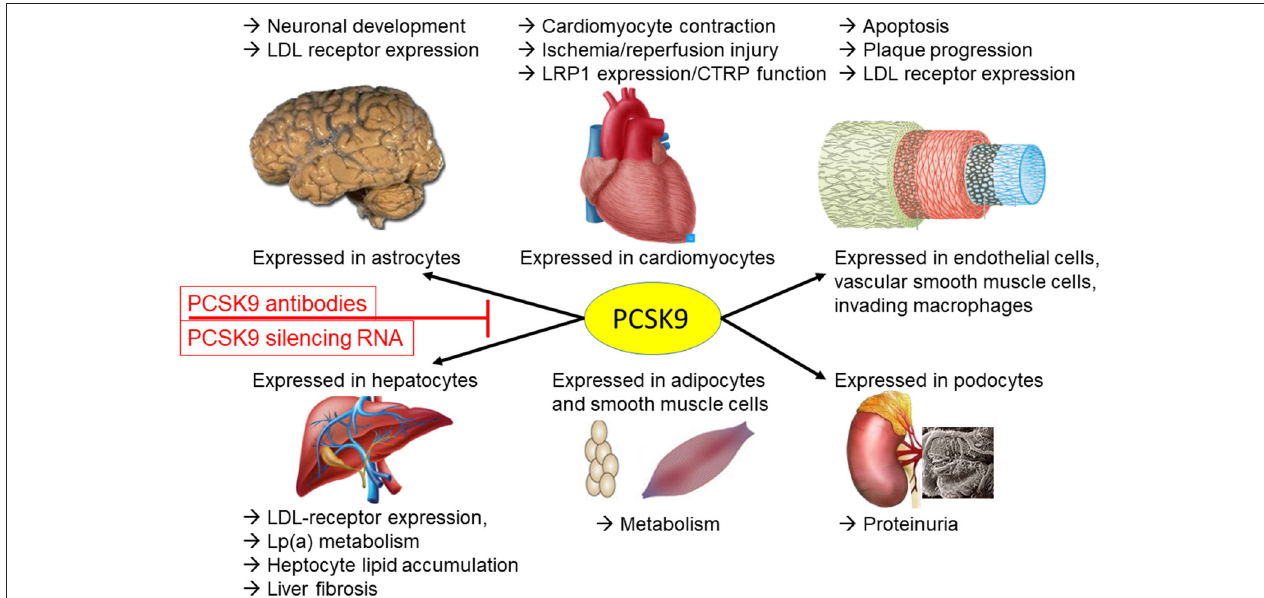
FIGURE 1 | PCSK9 is expressed in many cell types throughout the body. Here, PCSK9 can be released under certain pathophysiological conditions and/or comorbidities and either act locally or contribute to organ-organ interaction by increasing the circulating PCSK9 concentration. LDL, low-density lipoprotein; Lp(a), lipoprotein a; CTRP, C1q/TNF-related proteins; LRP1, low density lipoprotein receptor-related protein